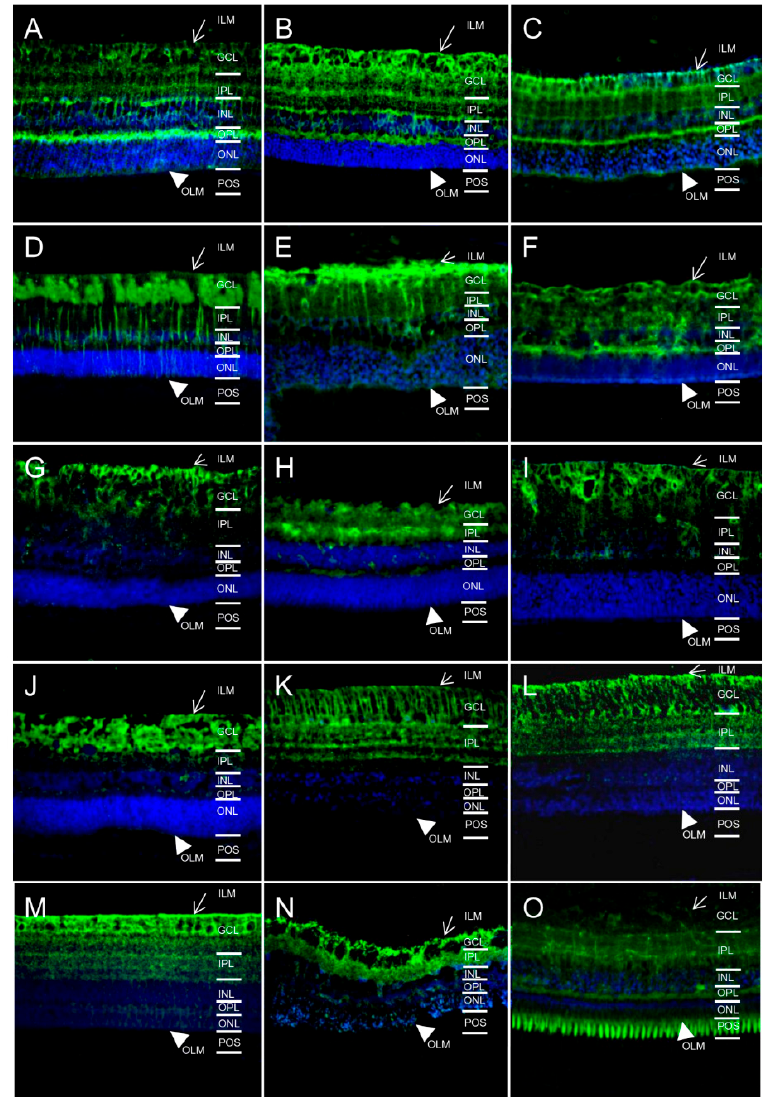
Figure 1. Predominant expression of aquaporin 4 (AQP4, green) at Muller glial cells in retinas of different species (magnification ×40). ILM, inner limiting membrane (arrow); GCL, ganglion cell layer; IPL, inner plexiform layer; INL, inner nuclear layer; OPL, outer plexiform layer; ONL, outer nuclear layer; OLM, outer limiting membrane (arrowhead); POS, photoreceptor outer segments. ( A ) mouse; ( B ) rat; ( C ) guinea pig; ( D ) horse; ( E ) cow; ( F ) sheep; ( G ) deer; ( H ) pig; ( I ) cat; ( J ) dog; ( K ) pigeon; ( L ) chicken; ( M ) pheasant; ( N ) sturgeon; ( O ) char. Cell nuclei: blue ((4 ′ ,6-diamidino-2-phenylindole) DAPI).